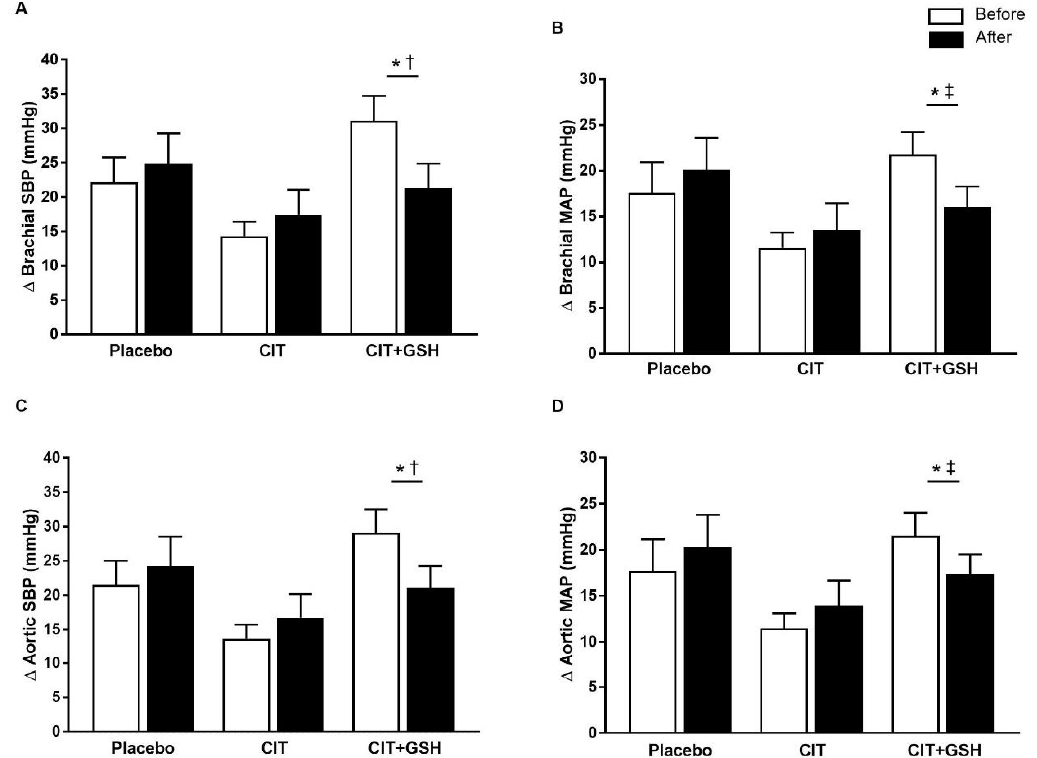
Figure 4. Changes ( ∆ ) in ( A ) the brachial systolic blood pressure SBP (SBP), ( B ) brachial mean arterial pressure (MAP), ( C ) aortic SBP, and ( D ) aortic MAP to the cold pressor test before and after supplementations. Abbreviations: CIT, citrulline; CIT+GSH, CIT+glutathione. * p < 0.05 before vs. after, † p < 0.05 vs. placebo and CIT, ‡ p < 0.05 vs. placebo. Table 4. Serum markers of arginine metabolism, glucose control, and oxidative